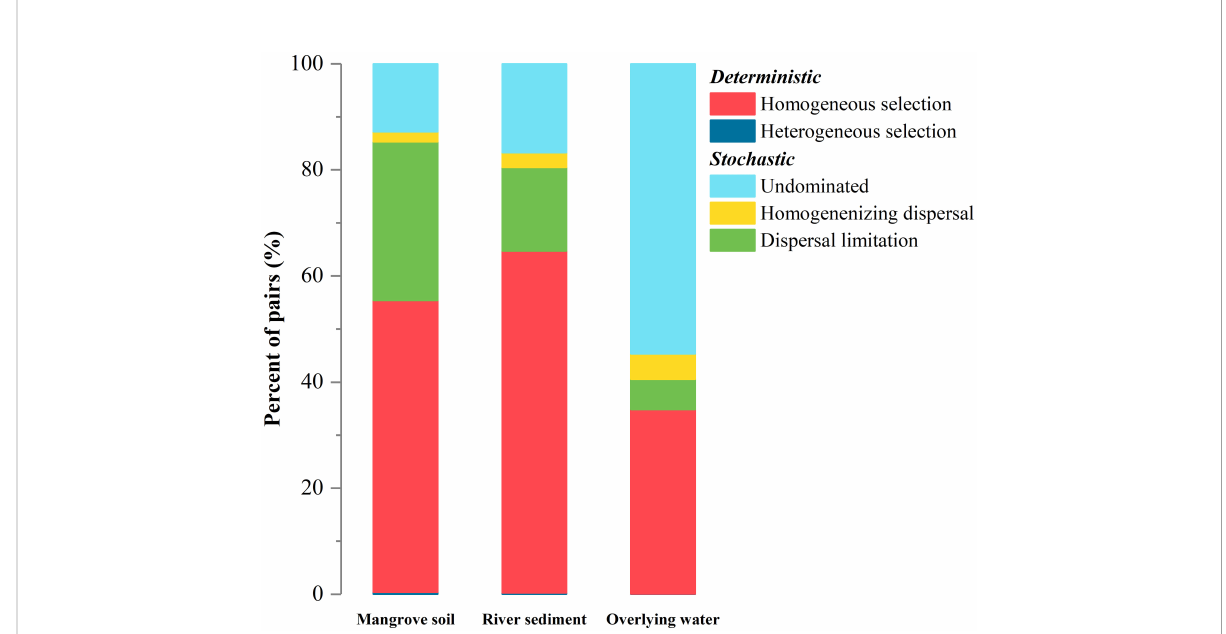
FIGURE 5 Relative importance of different ecological processes to bacterial community assemblies in different